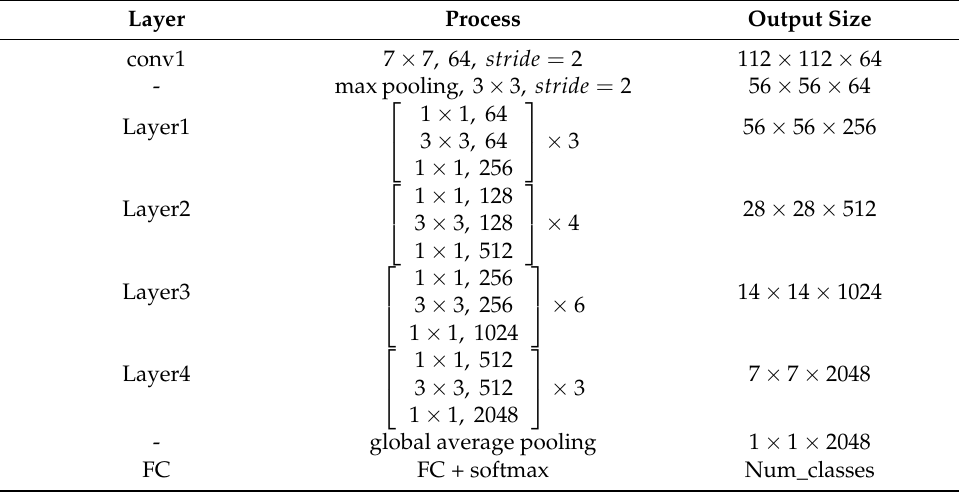
Table 1. Network structure of